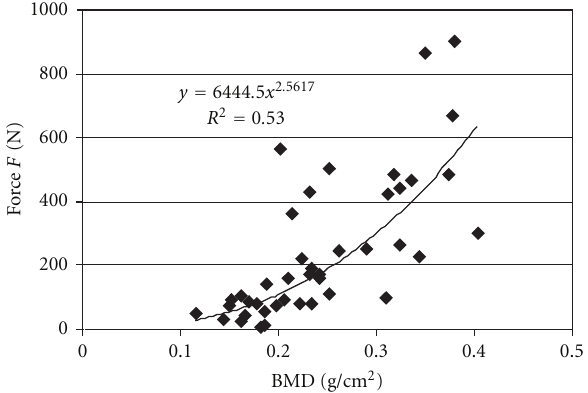
Figure 4: Relation between force F and bone mineral density BMD.